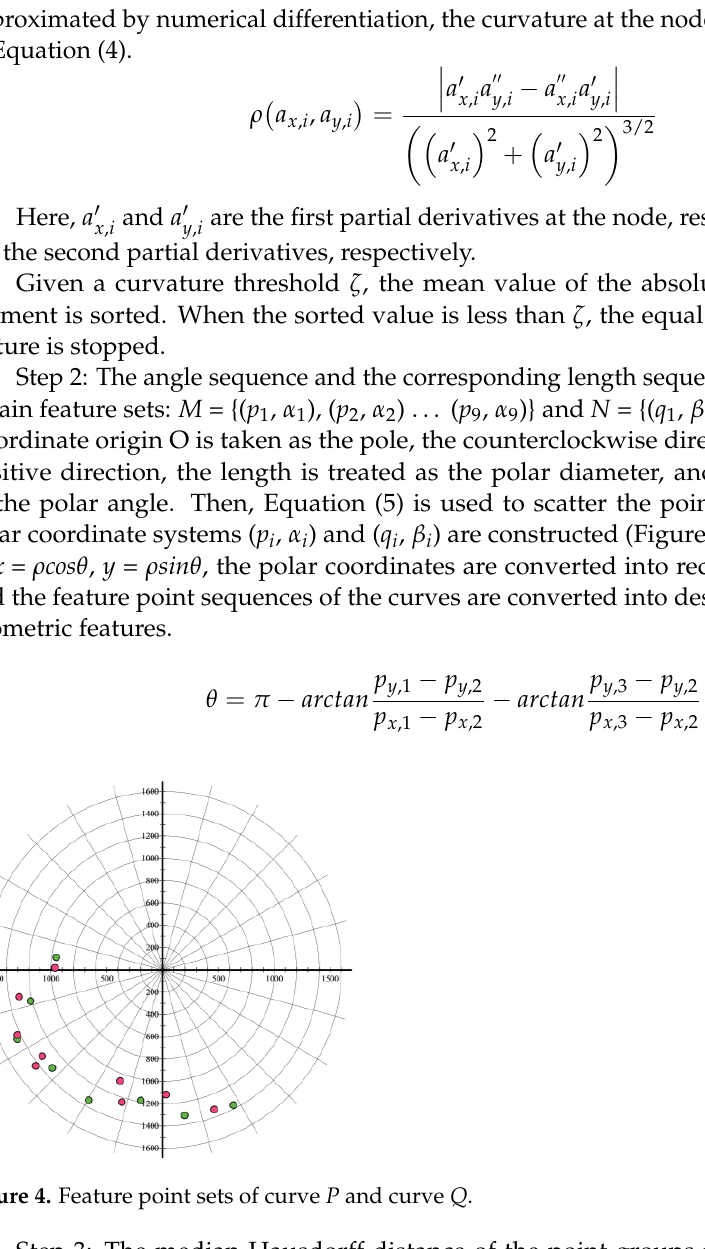
Figure 3. Curve shape feature extraction: ( a ) curve P ; and ( b ) curve Q .